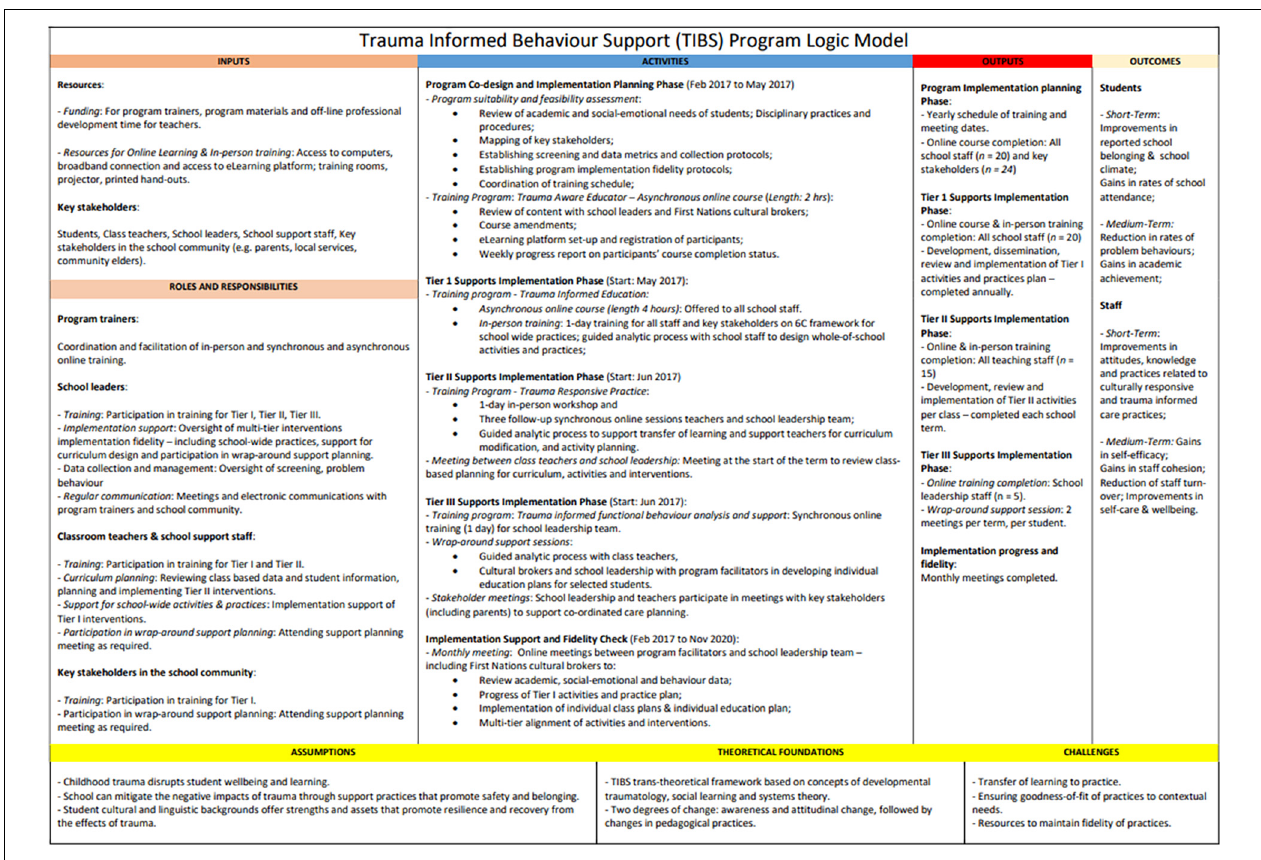
FIGURE 1 | Trauma-informed behavior support (TIBS) program logic